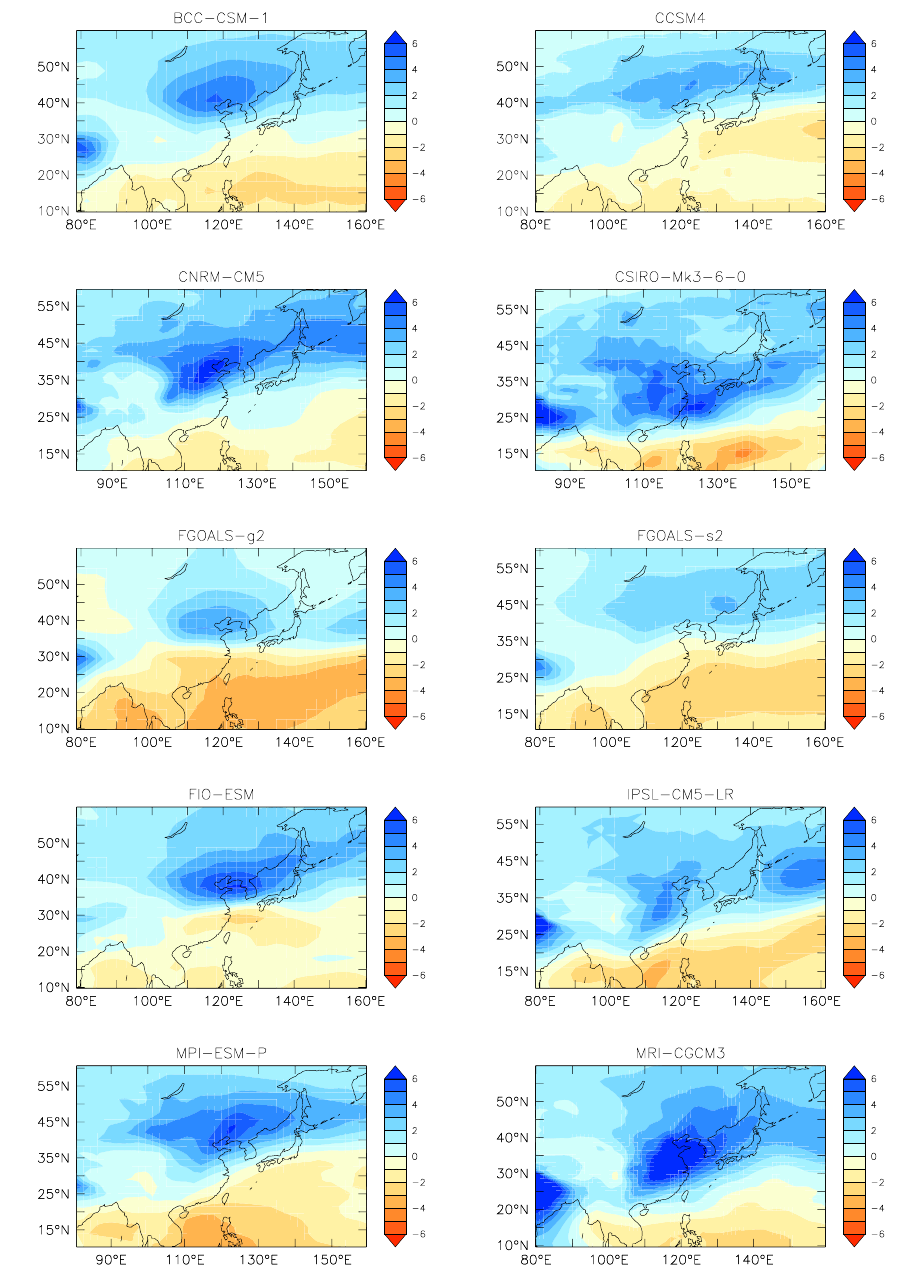
Fig. 7. Same as Fig. 6, but for the changes of water vapour content. Units: kgm − 2